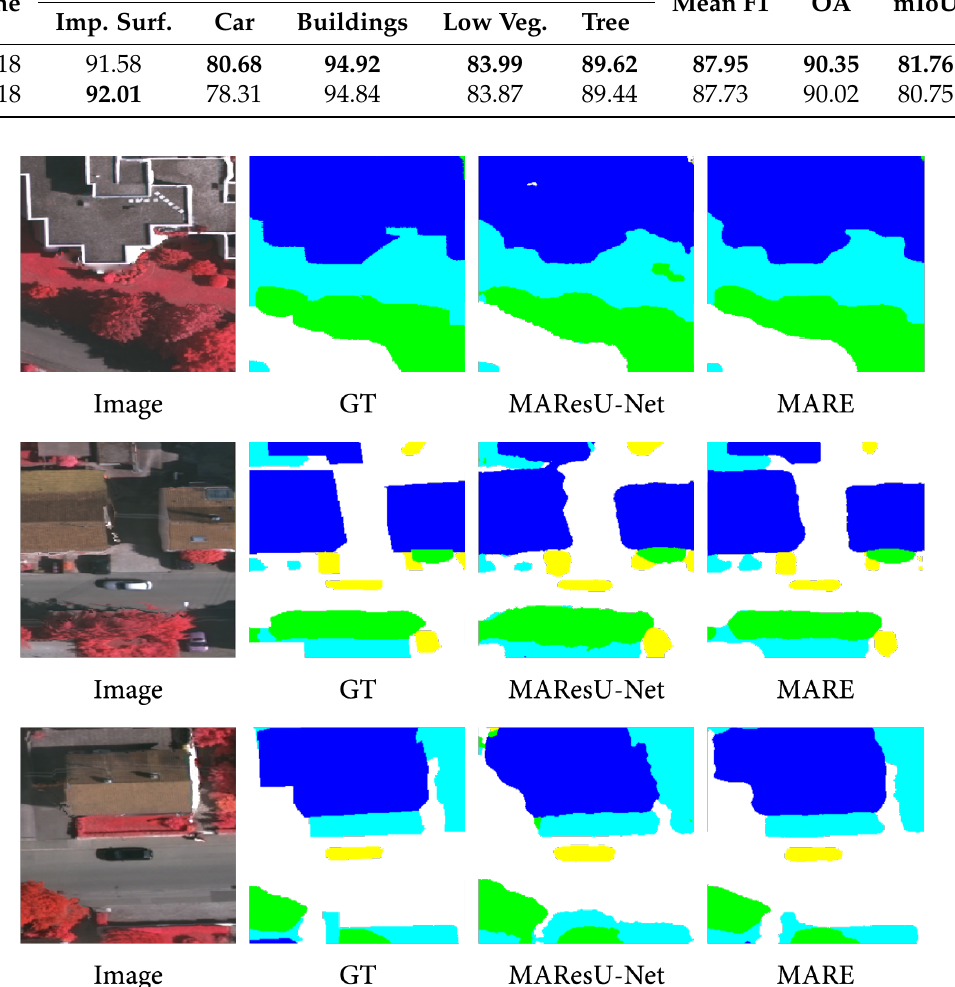
Figure 6. Segmentation masks comparison between MAResU-Net and MARE, both with a ResNet-18 as the